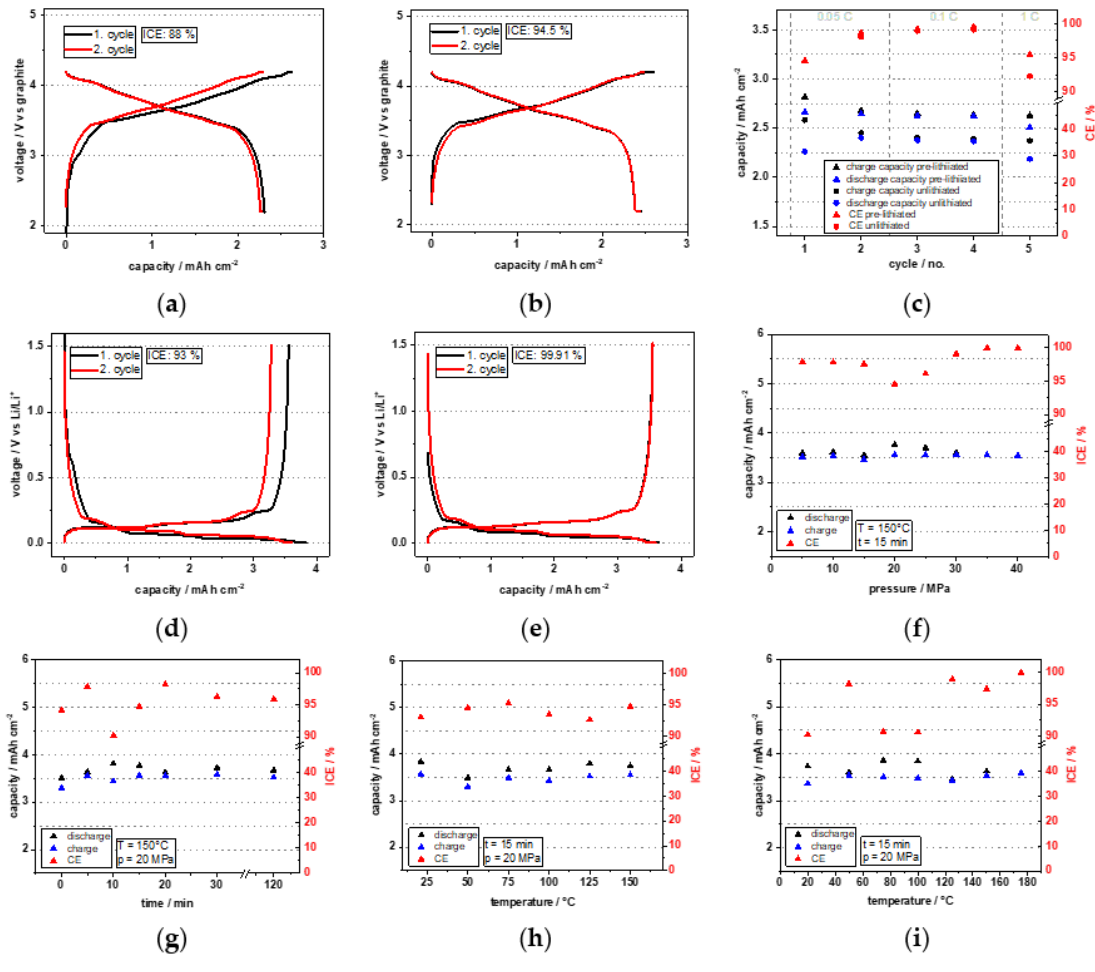
Figure 2. Voltage profiles: Electrochemical determination of capacity loss during cell formation in NCM full cell with unlithiated graphite electrode showing 12% capacity loss after the first cycle (ICE: 88%) ( a ) and with pre-lithiated graphite electrode showing 5.5% capacity loss after the first cycle (ICE: 94.5%) ( b ); charge and discharge capacities for unlithiated and pre-lithiated graphite electrodes measured electrochemically in NCM full cells for the first five cycles ( c ); electrochemical determination of SEI induced capacity loss in half cells with unlithiated graphite anode showing 7.2% capacity loss after the first cycle ( d ) and with pre-lithiated graphite anode showing 2.1% capacity loss after the first cycle ( e ); initial Coulomb efficiencies of pre-lithiated material depending on pre-lithiation parameters pressure (15 min, 150 ◦ C) ( f ), time (20 MPa, 150 ◦ C) ( g ), temperature at low pressure (15 min, 20 MPa) ( h ) and temperature in combination with higher pressure (15 min, 40 MPa) ( i